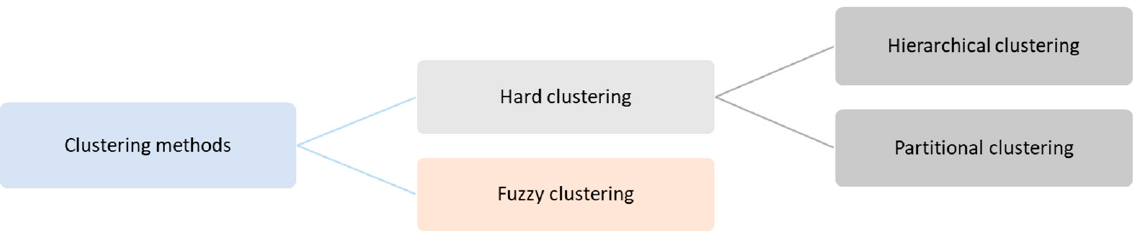
Figure 2. An overview of clustering methods [27].